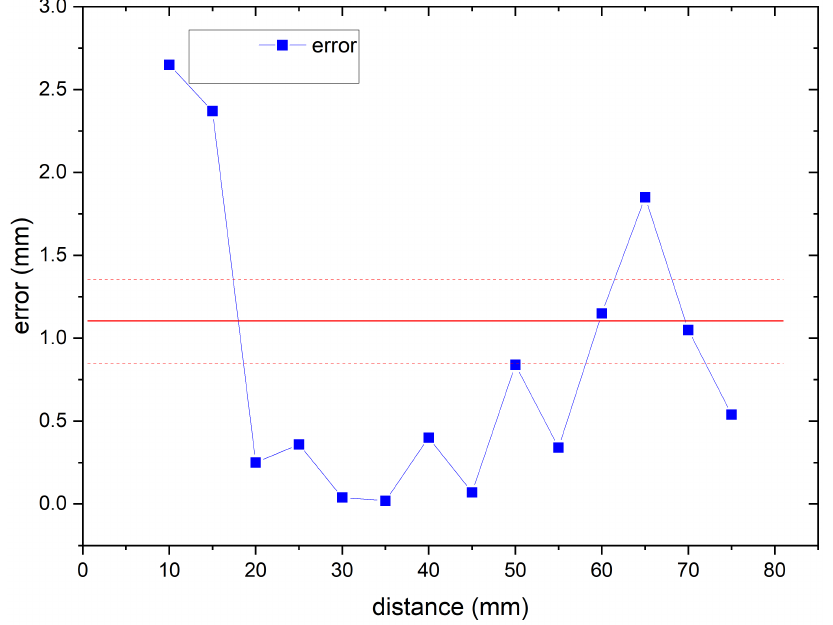
Figure 9. Difference between programmed value and the measured physical value, the red line represents the error mean value and dotted red line the confidence